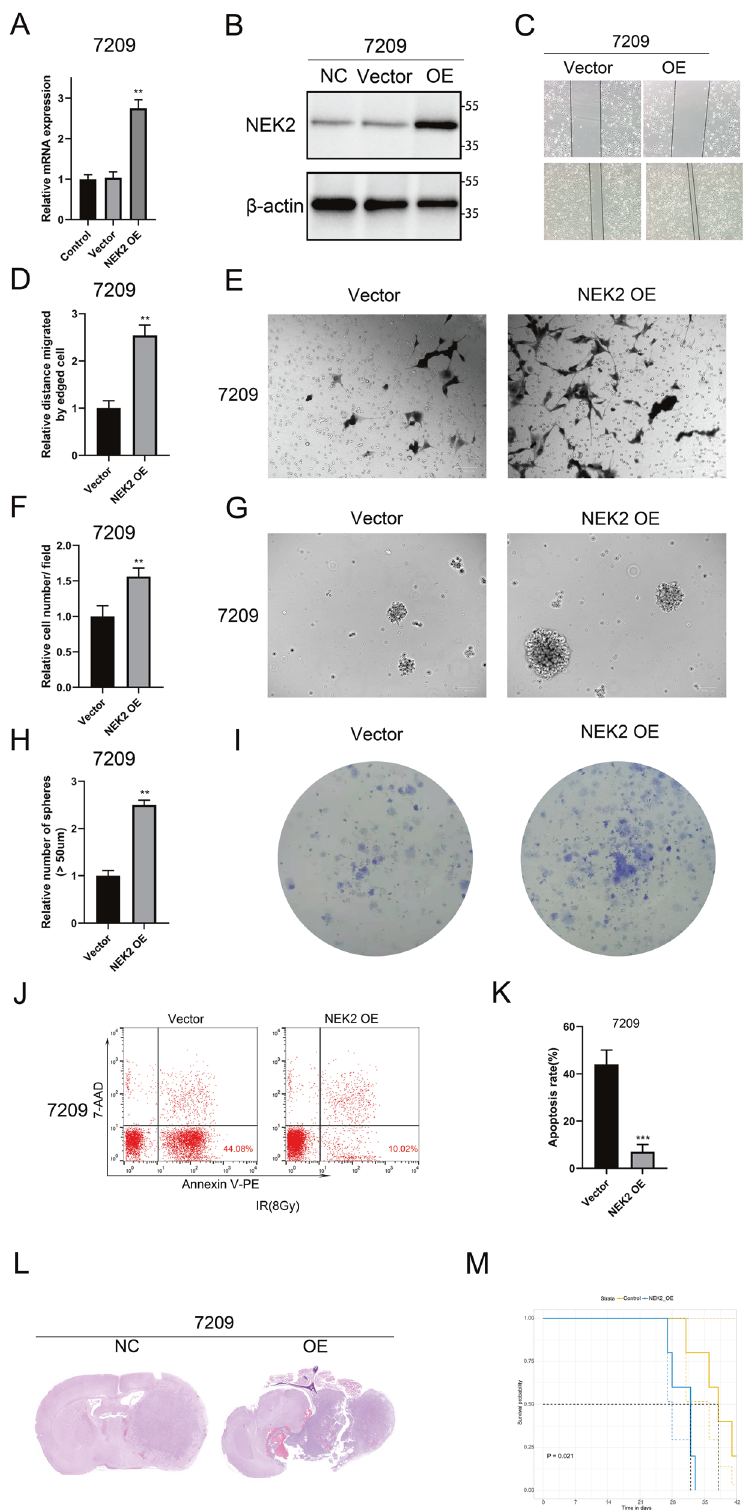
af fi nity-puri fi ed complex, con fi rming that there was an interaction between NEK2 and NIK. CO-IP assays further validated this fi nding (Fig. 6B, C). Moreover, we used NIK speci fi c antibody to obtain puri fi ed protein complexes of nontreated GBM cells and NEK2 knockdown GBM cells by immunoprecipitation. Nonspeci fi